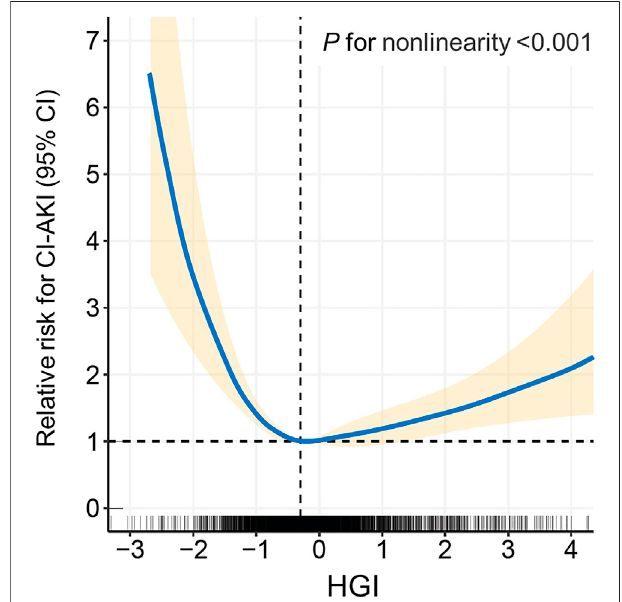
FIGURE 4 | Restricted cubic spline (RCS) analysis of the HGI with the incidence of CI-AKI. The spline plot showed the relative risk for CI-AKI according to HGI levels on a continuous scale. Four knots were chosen for coding HGI with the restricted cubic spline function. HGI indicates hemoglobin glycation index; CI-AKI, contrast-induced acute kidney